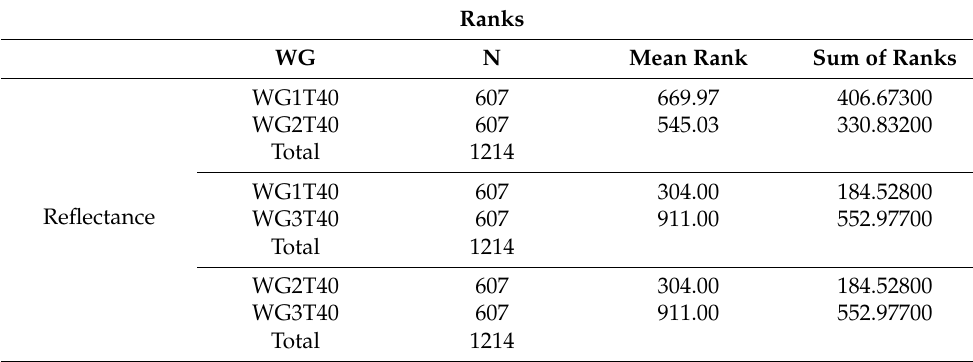
Table A11. Ranks table of the Mann–Whitney test for specular solar reflectance, according to the holding time of 40 min.